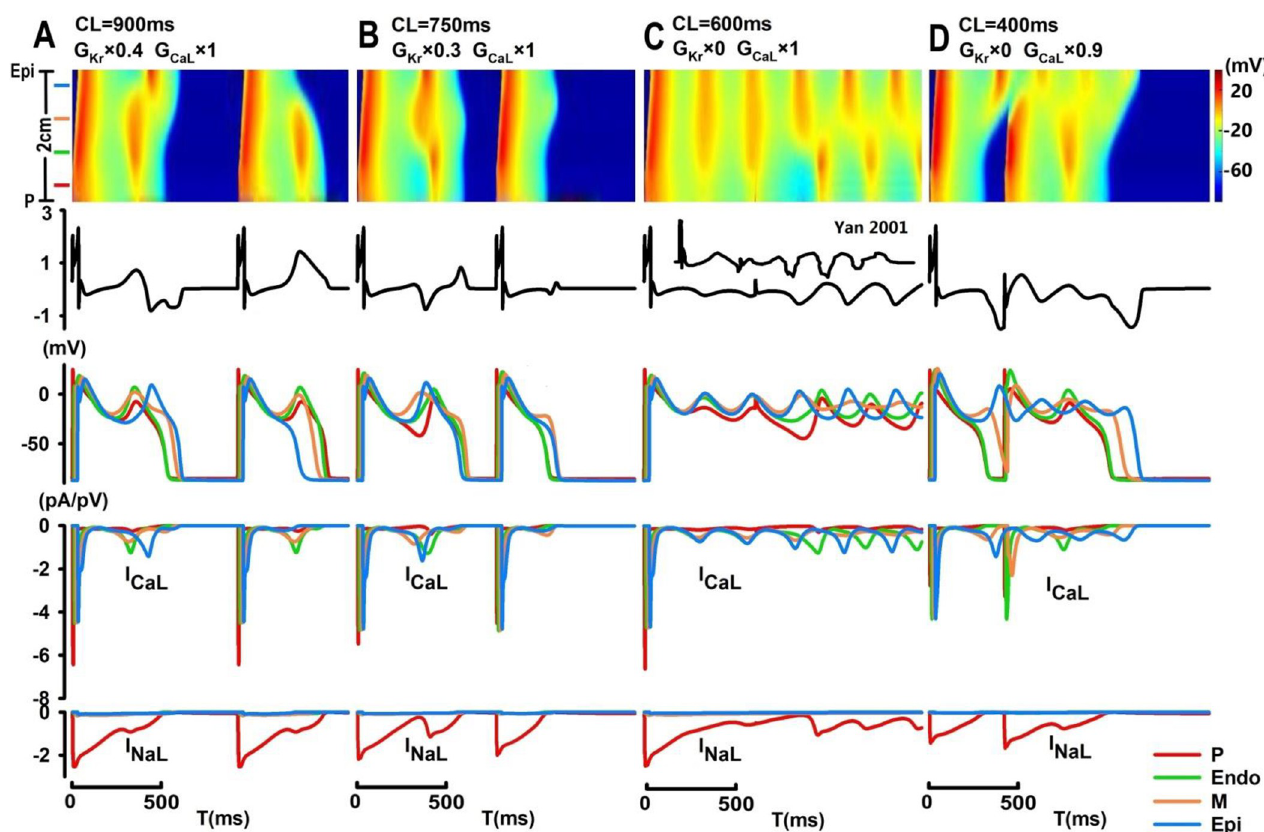
Fig 7. Computer simulation of spatially desynchronized EAD events and oscillatory excitation patterns. (A) Partially synchronized EAD development in P, Endo and M cells preceded the beat-to-beat spontaneous onset of EAD in the epicardium; (B) focal EAD arising from the midmyocardium triggered bidirectional excitation with a late-appearing spontaneous onset of EADs in the P tissue; (C) spatially discordant development of oscillating EAD and ECG patterns with sustained alternating EAD occurrences in the M- and epicardium or in the Purkinje tissue and endocardium; (D) localized EAD events in the epicardium during previous repolarization collided with the current wavefront of depolarization and triggered self-terminated oscillatory EAD and ECG patterns.